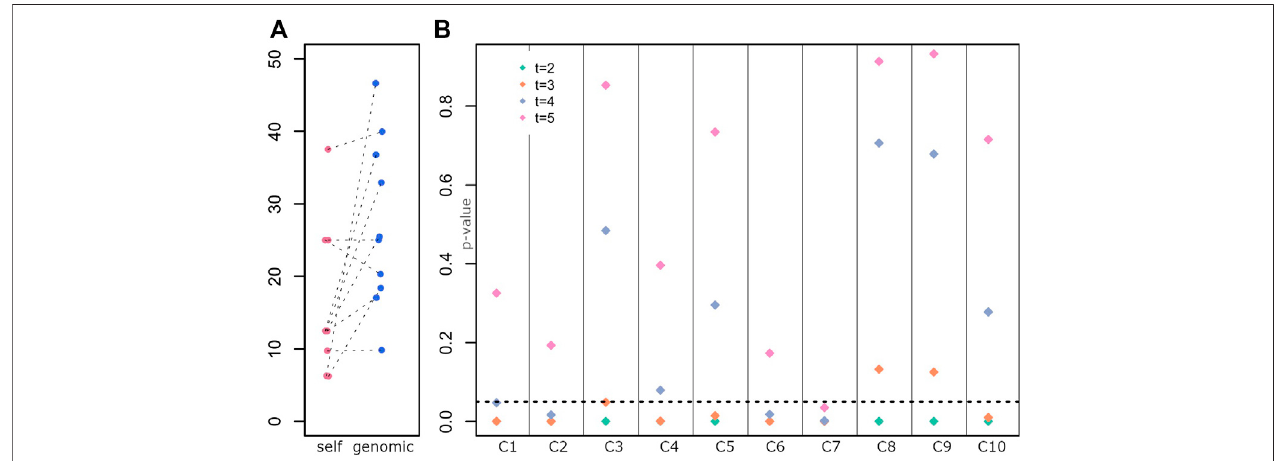
FIGURE 3 | Determination of the generation of the last full indigenous ancestor (A) Distribution of self-declared Amerindian ancestry (self) and genomic estimates (genomic).Eachdotisanindividual. (B) Testofamodelwithafullindigenousancestorineachgenerationforeachindividual. p -valuesforrejectingthenullhypothesisare on the y-axis, and individuals are displayed along the